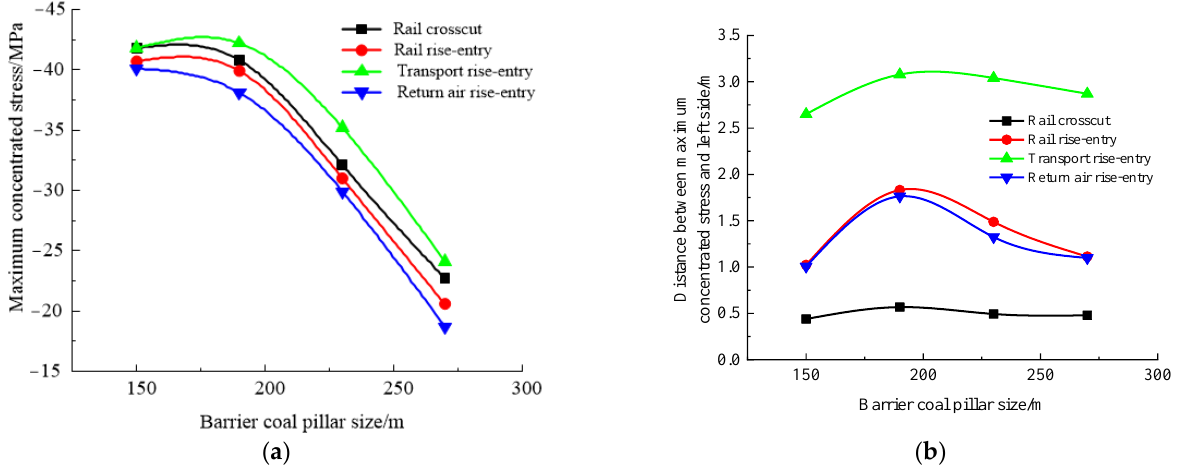
Figure 14. Monitoring results of convergence in roadway-concentrated areas under different sizes of rise-entry barrier coal pillar conditions. ( a ) Roof-to-floor convergence, ( b ) Two-sided convergence.